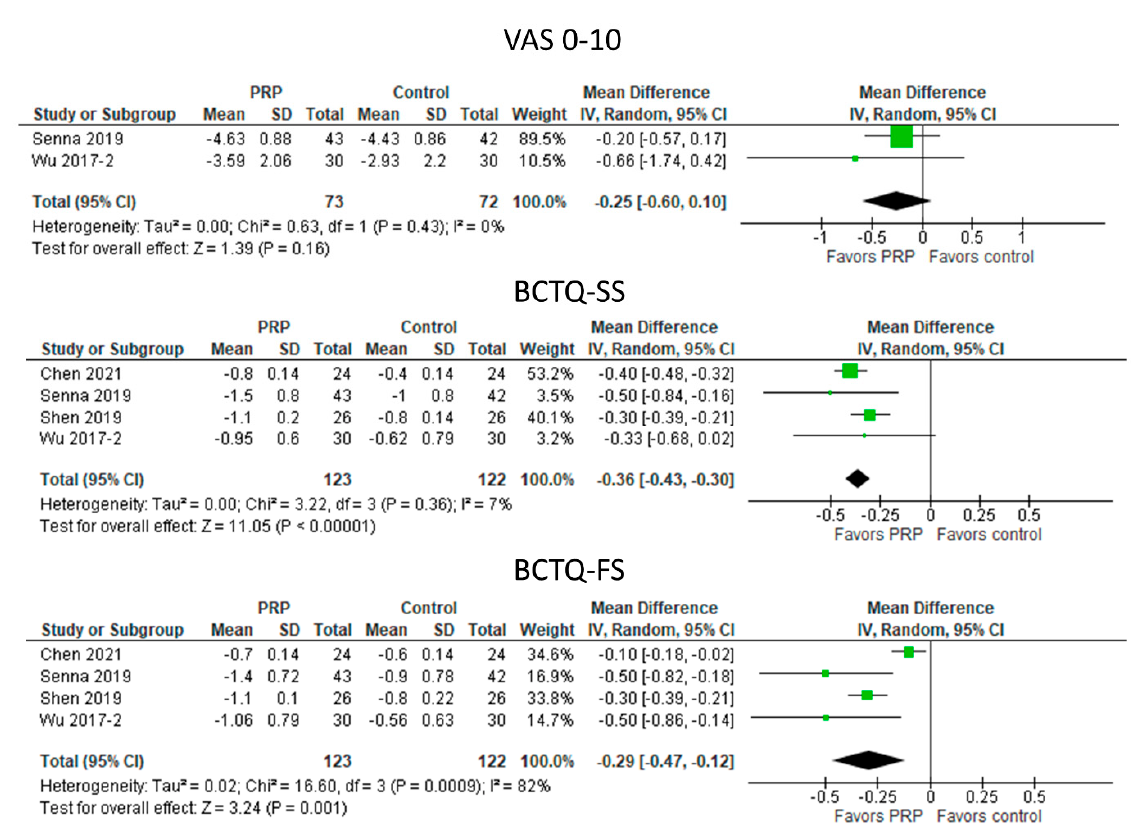
Figure 6. Meta—analysis of UPIT with PRP vs. control treatments. VAS, visual analogue scale; BCTQ—SS, Boston Carpal Tunnel Questionnaire—symptom scale; BCTQ—FS, Boston Carpal Tun-